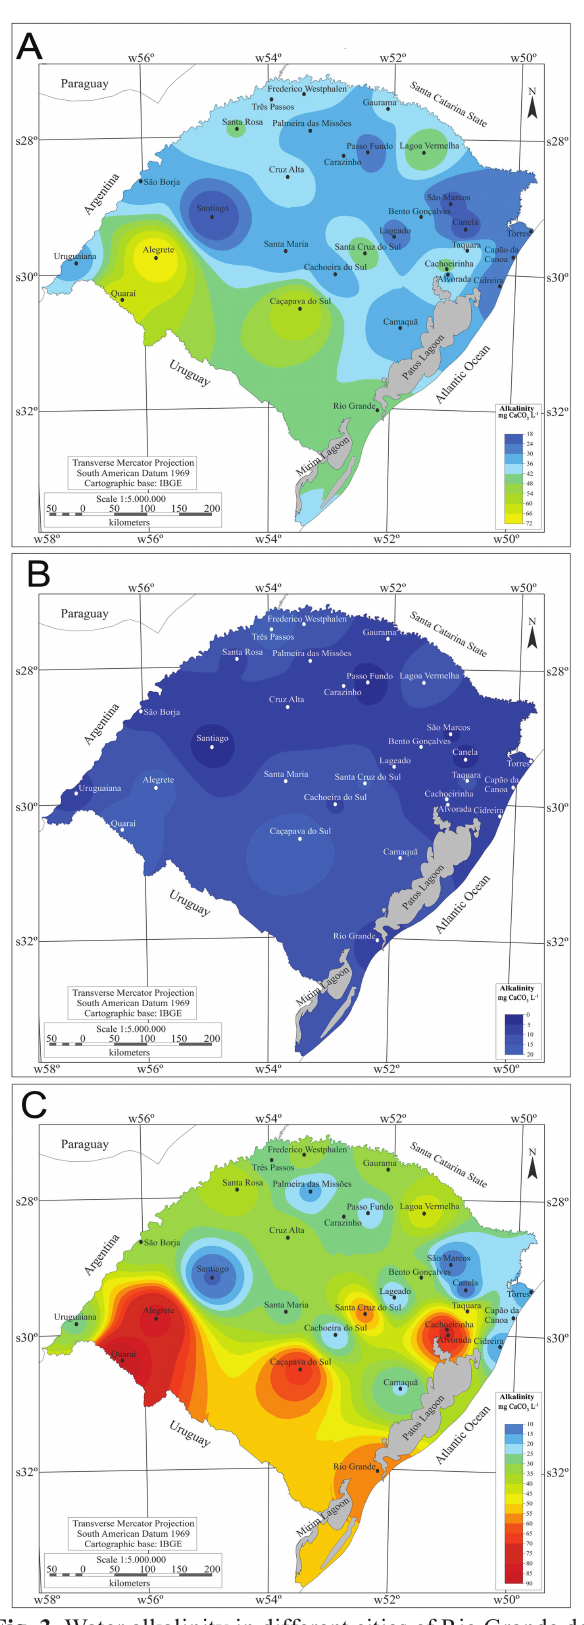
Fig. 4. Water turbidity in different cities of Rio Grande do Sul in the period of 1996 to 2011 (A) mean, (B) minimum and (C) maximum values (Source